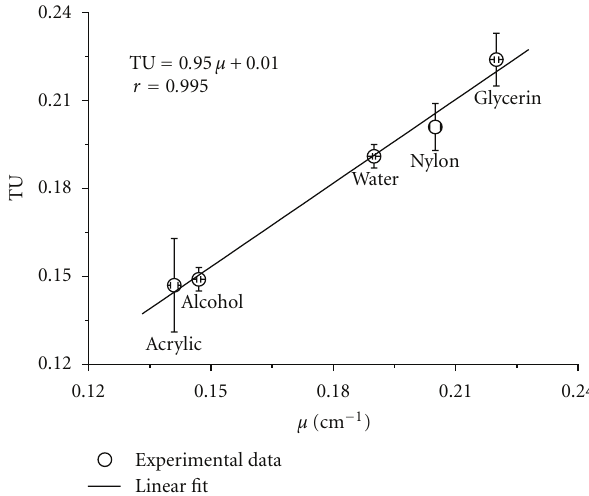
Figure 4: Experimental relationship between the tomographic units (TU) of the images obtained by the tomograph and linear attenuation coe ffi cients ( μ ) for homogeneous substances used during the calibration of the tomograph. The vertical error bars represent the standard deviation of the TU values in the matrix of selected data. The horizontal error bars depict the mean standard deviation ( n =